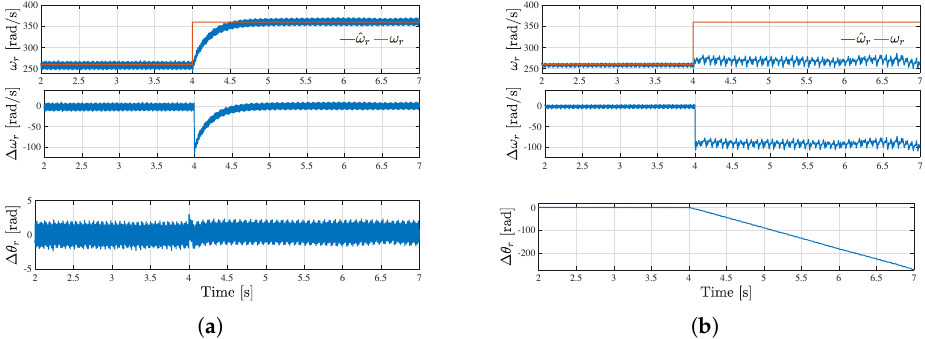
Figure 10. Simulation results during change in rotor speed. ( a ) Simulation results from the proposed SMO-MRAS estimator and ( b ) simulation results from the standard MRAS estimator. At t = 4 s, the rotor speed is suddenly changed from 260 to 360 rad/s. It can be seen in Figure 10b that the rotor speed from the SMC-MRAS estimator follows the change in speed while the rotor speed from the PI-MRAS estimator